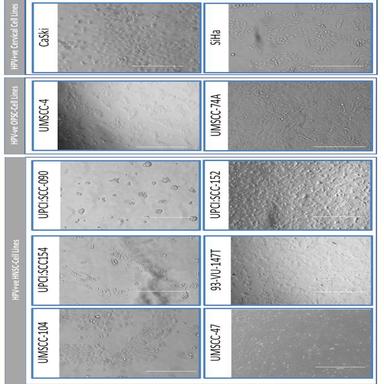
Brightfield imaging x10 on EVOS XL Core. Scale = 1000 μm.